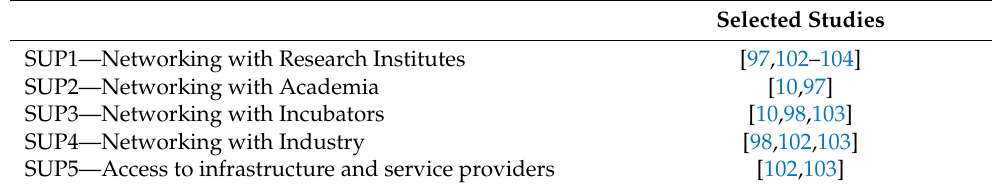
Table 7. Construction of the networking and infrastructure support factor from the